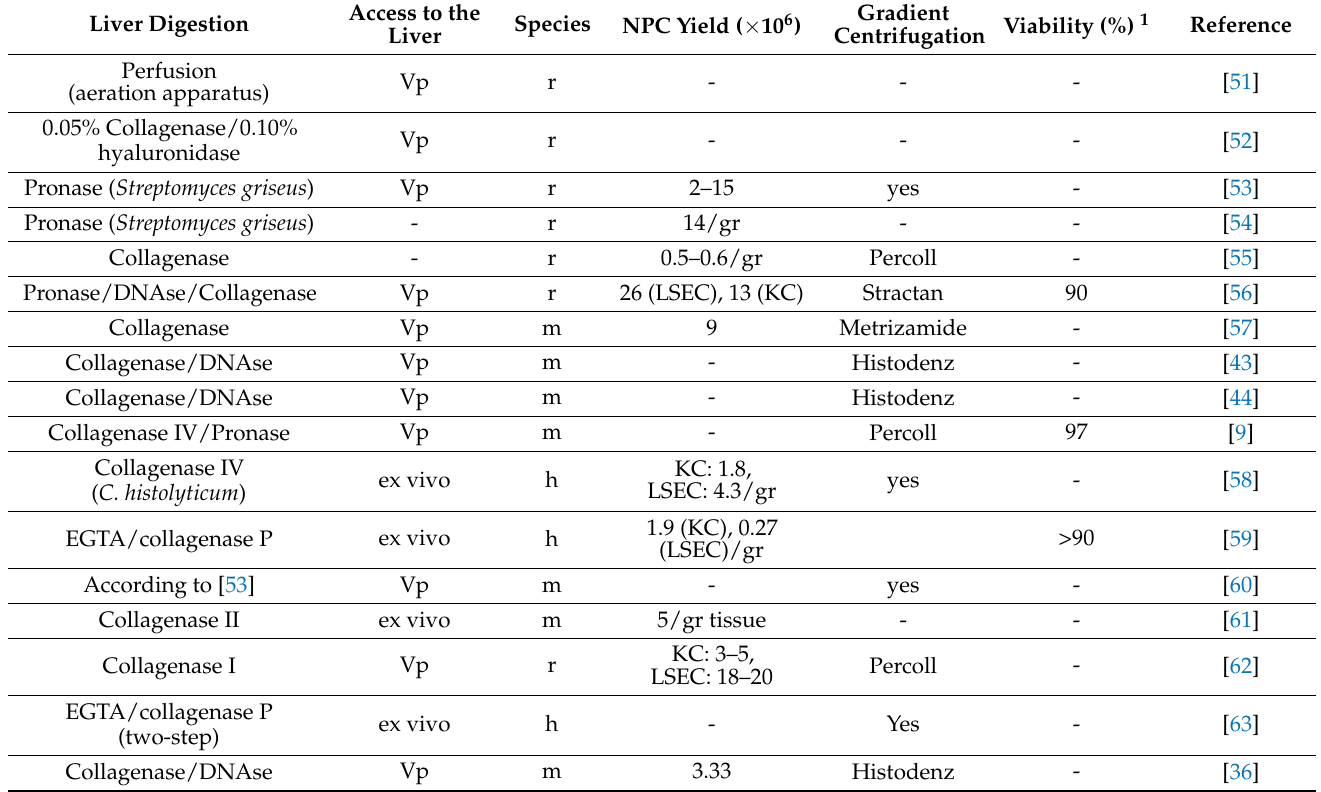
Table 1. Protocols for liver NPC